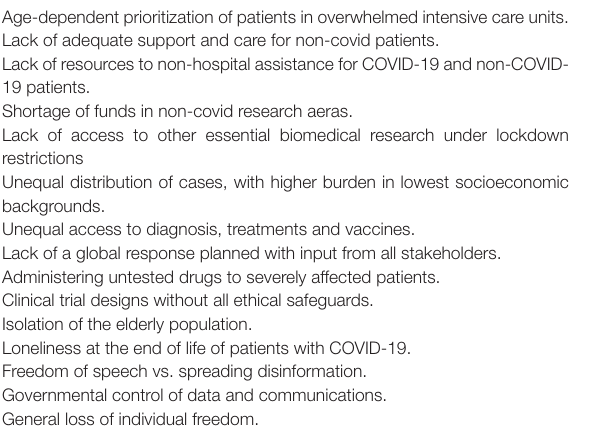
TABLE 1 | Examples of principal pandethic challenges in the COVID-19 syndemic. Age-dependent prioritization of patients in overwhelmed intensive care units. Lack of adequate support and care for non-covid patients. Lack of resources to non-hospital assistance for COVID-19 and non-COVID- 19 patients. Shortage of funds in non-covid research aeras. Lack of access to other essential biomedical research under lockdown restrictions Unequal distribution of cases, with higher burden in lowest socioeconomic backgrounds. Unequal access to diagnosis, treatments and vaccines. Lack of a global response planned with input from all stakeholders. Administering untested drugs to severely affected patients. Clinical trial designs without all ethical safeguards. Isolation of the elderly